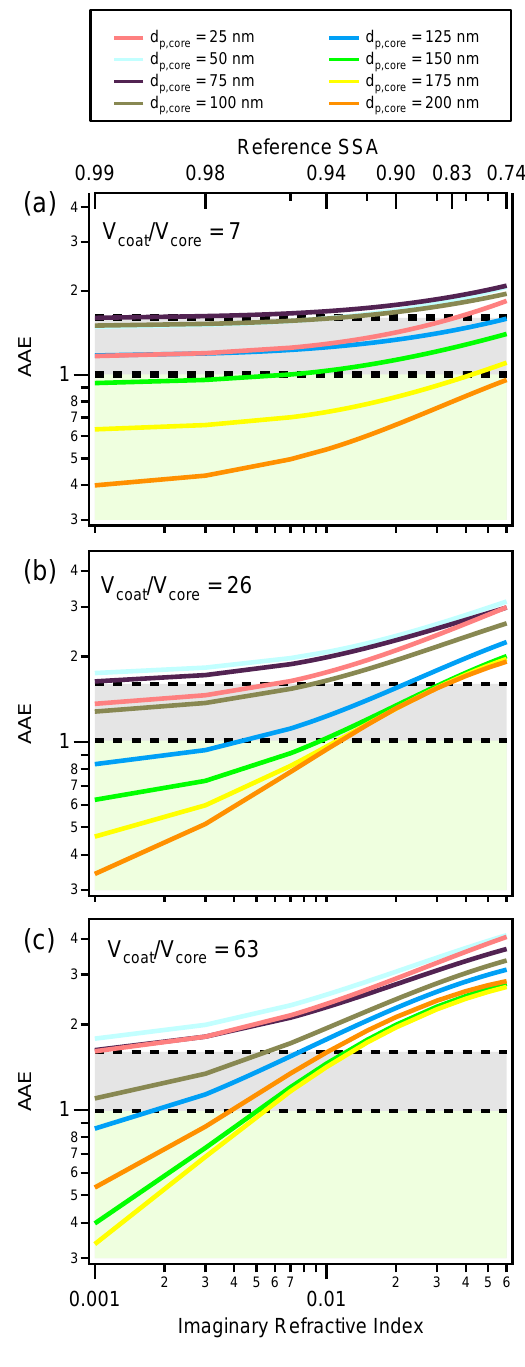
Fig. 9. The AA E 380nm − 750nm calculated as a function of the imag- inary RI for different assumed BC core diameters (indicated by the different color lines) and C Brown shell thicknesses. Calculations were done using d p, particle / d p, core equal to (a) 2, (b) 3 and (c) 4. The corresponding volume ratios are given on the figure. For ref- erence, the SSA values associated with the given imaginary refrac- tive indices are shown on the top axis (calculated for a d p =200nm particle at 380nm). The gray regions in all panels indicates the area where 1 < AA E 380nm − 750nm > 1.6 and the green region where AA E 380nm − 750nm <